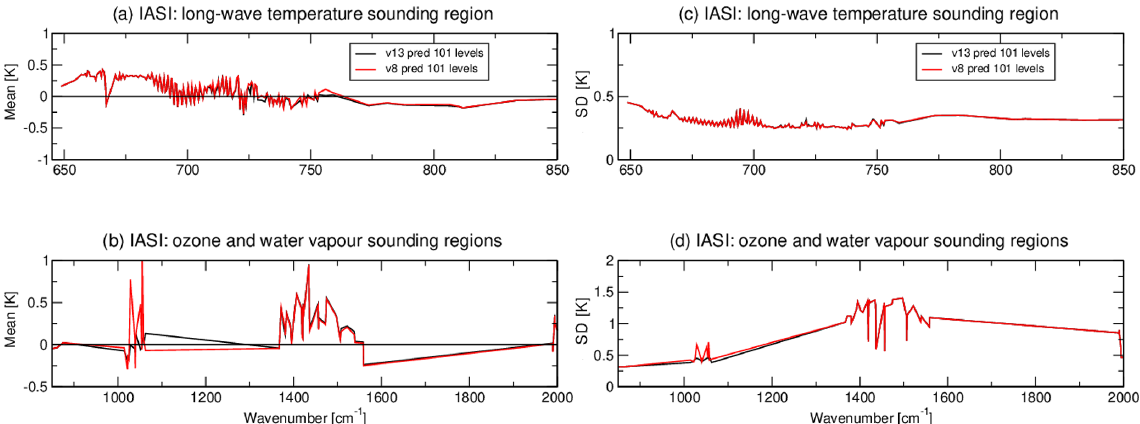
Figure 15. As Fig. 14 but with RTTOV v13 coefficients that are based on the new v13 predictors and the v8 predictors (variable O 3 and CO 2 on 101 levels).